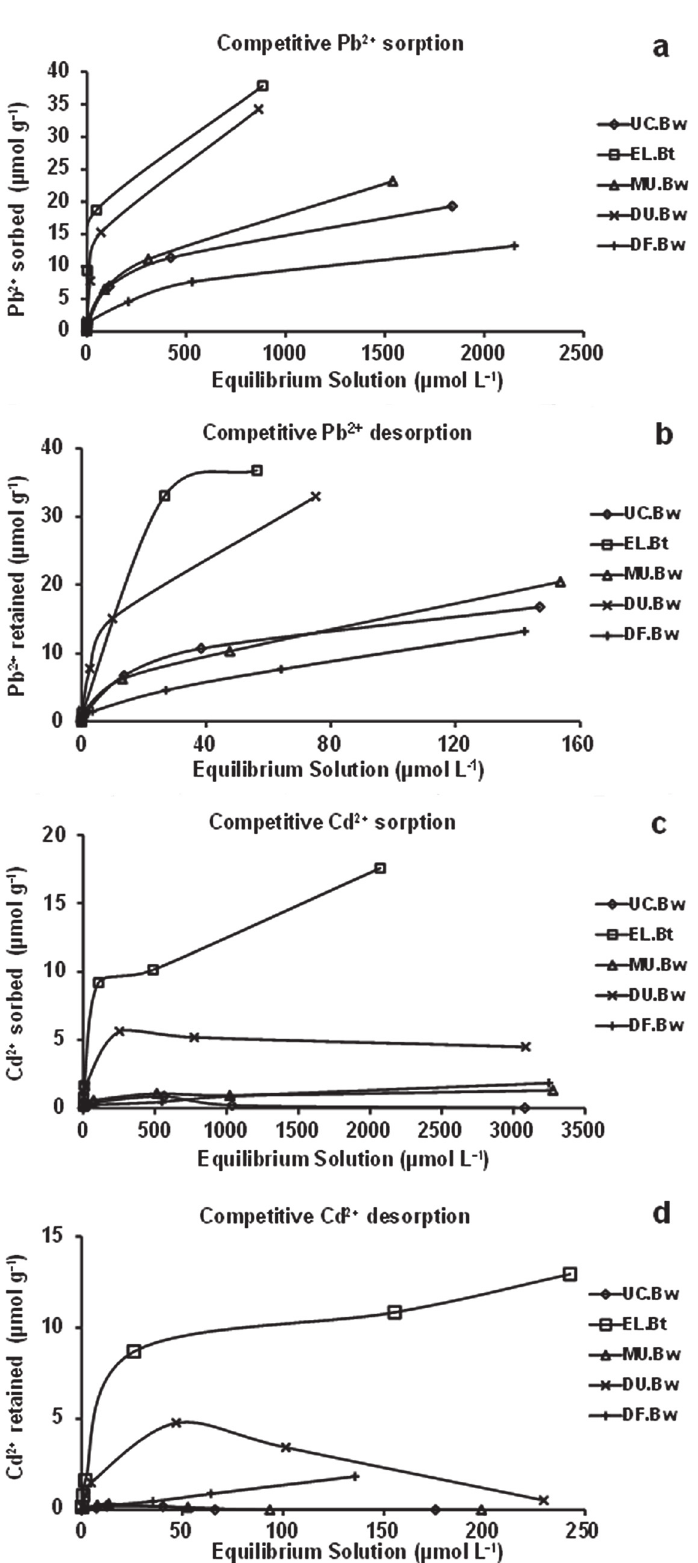
Fig 2. Competitive sorption (a and c) and desorption (b and d) isotherms of Pb 2+ and Cd 2+